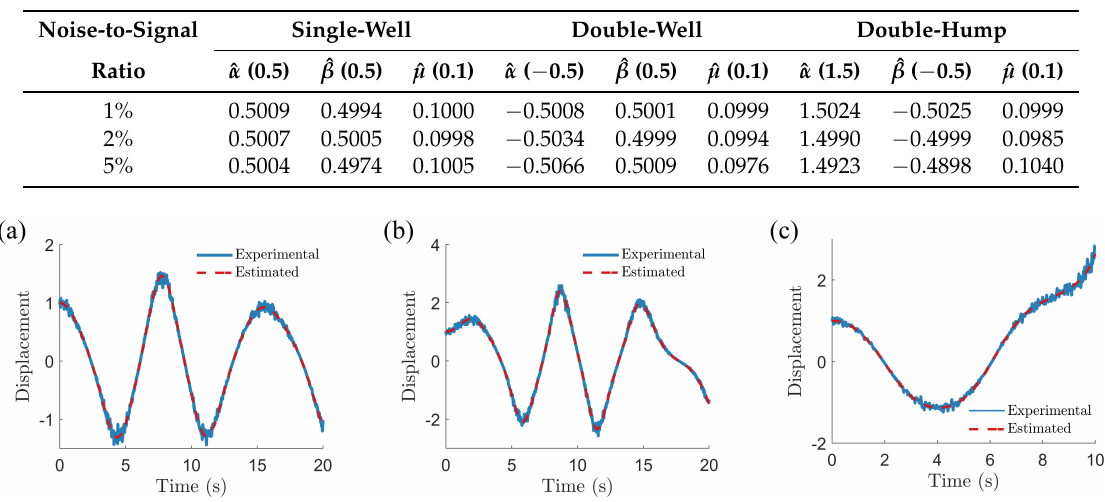
Figure 5. Noisy experimental data (noise-to-signal ratio of 5%) and estimated response using identified parameters for three van der Pol–Duffing oscillators: ( a ) single-well, ( b ) double-well, and ( c )